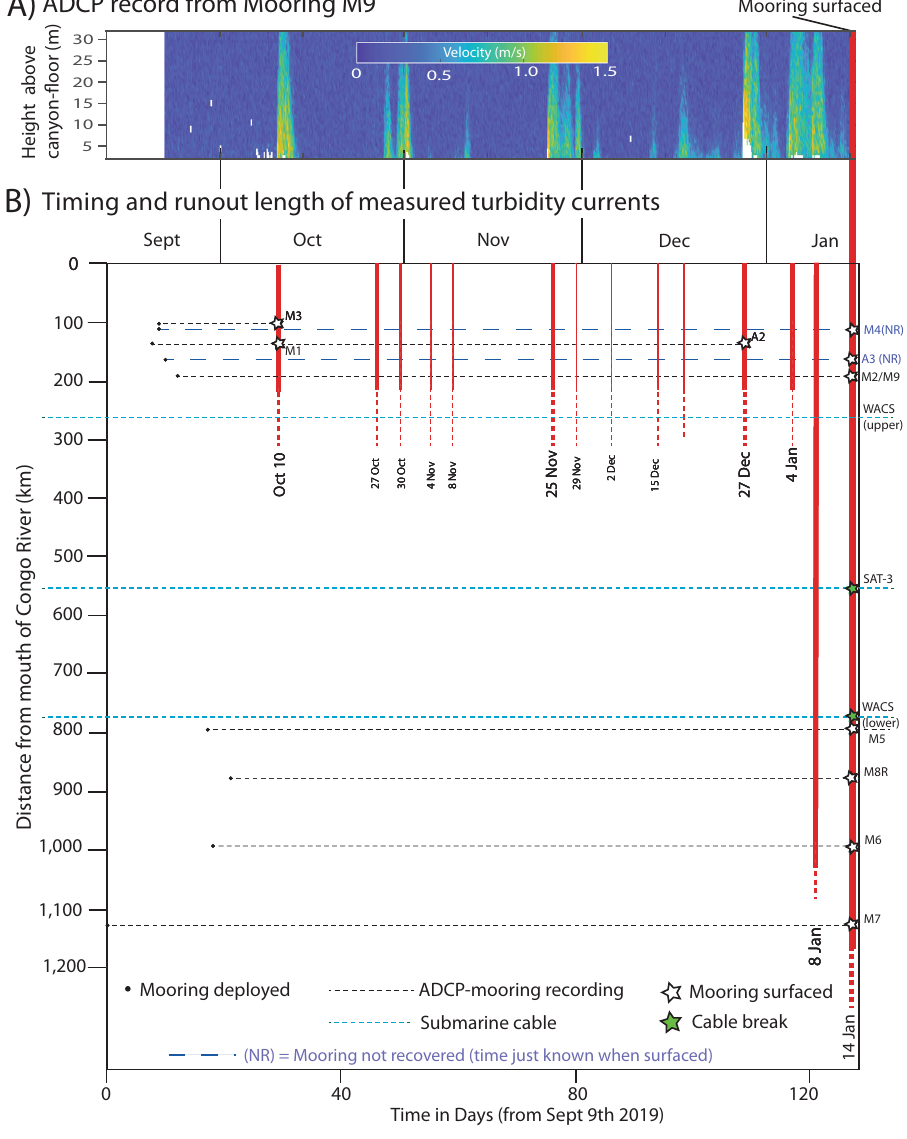
Fig. 2 Timing and runout distance of turbidity currents measured from September 2019 to January 2020 along the Congo Canyon and Channel system. A ADCP time series of velocities measured at mooring M9, showing occurrence of turbidity currents. B Plot of event timing against distance from Congo River mouth, as measured along the sinuous canyon-channel axis. Red vertical lines denote fl ow events (dotted where termination uncertain), and indicate their runout distances, with the most powerful January 14 – 16 th event in bold. Dotted horizontal lines denote a mooring site or submarine cable. The times of mooring deployment are shown, together with when moorings or cables broke due to turbidity currents. Two moorings (M4 and A3) were not recovered ( ‘ NR ’ ); fl ow timings at these two sites are derived from when mooring reached the ocean surface, and an assumed rise rate of 150 m/min (as seen during earlier